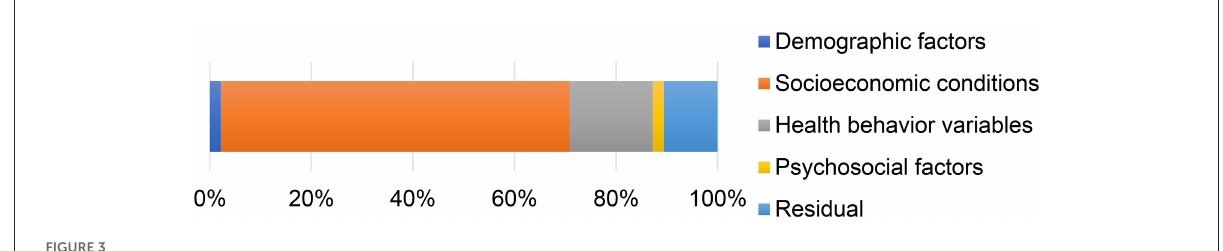
FIGURE3 Contribution to inequality in obesity among the elderly in China